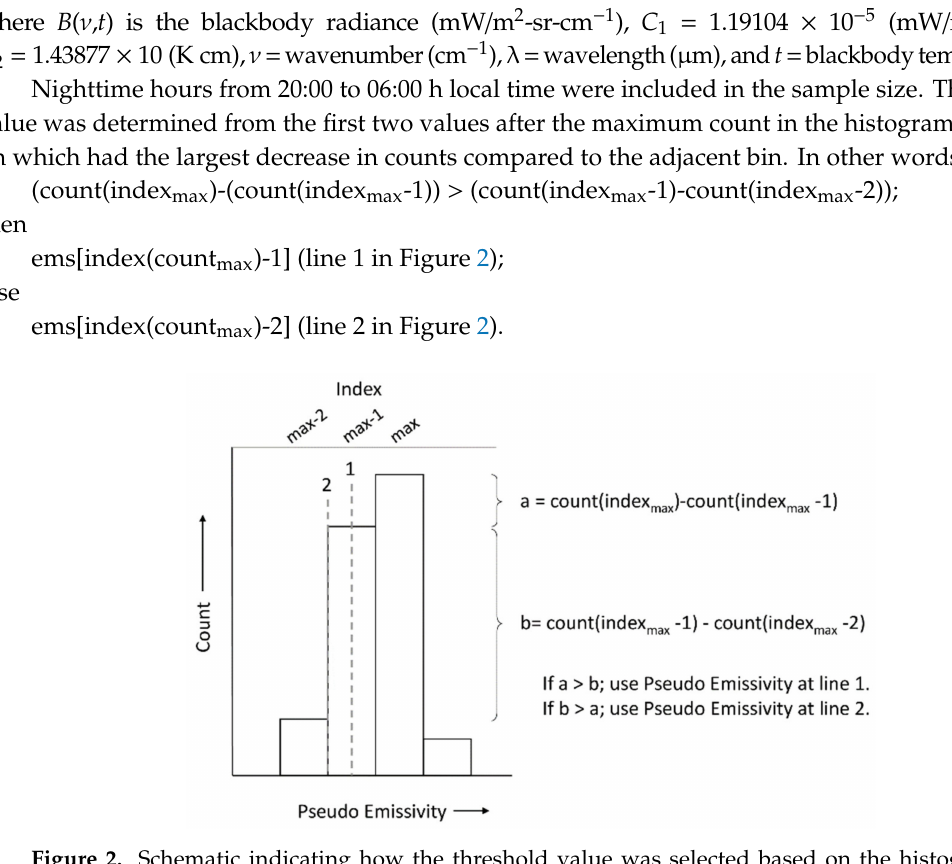
Figure 2. Schematic indicating how the threshold value was selected based on the histogram of pseudo-emissivity at each